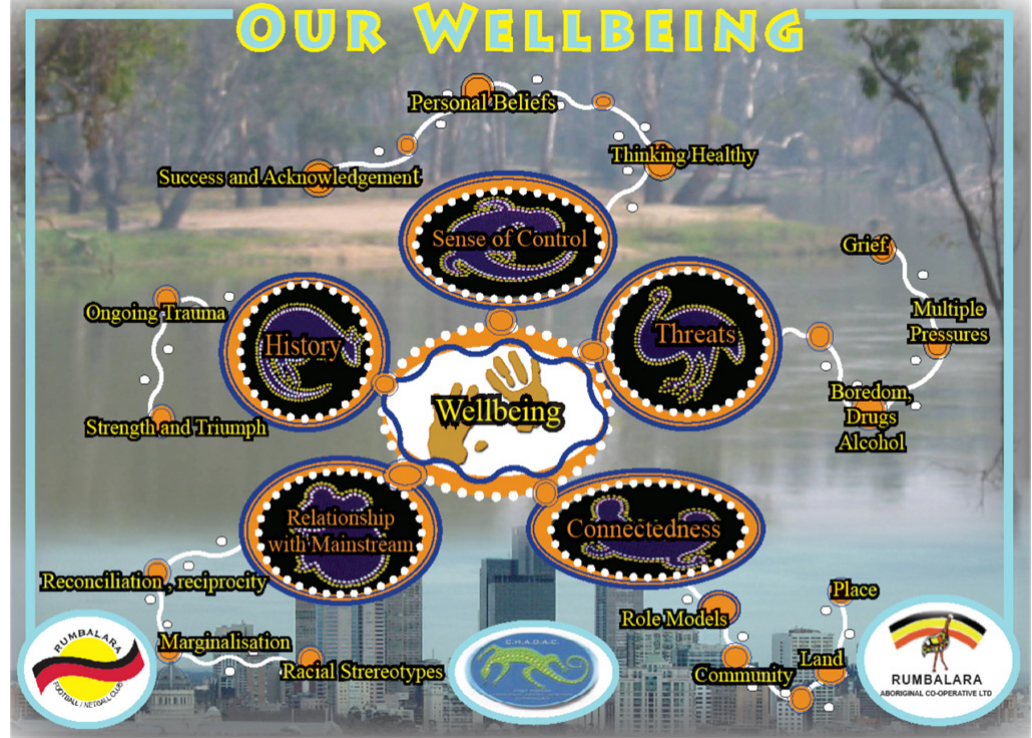
Figure 2. “Our Wellbeing” A holistic model of Indigenous Wellbeing